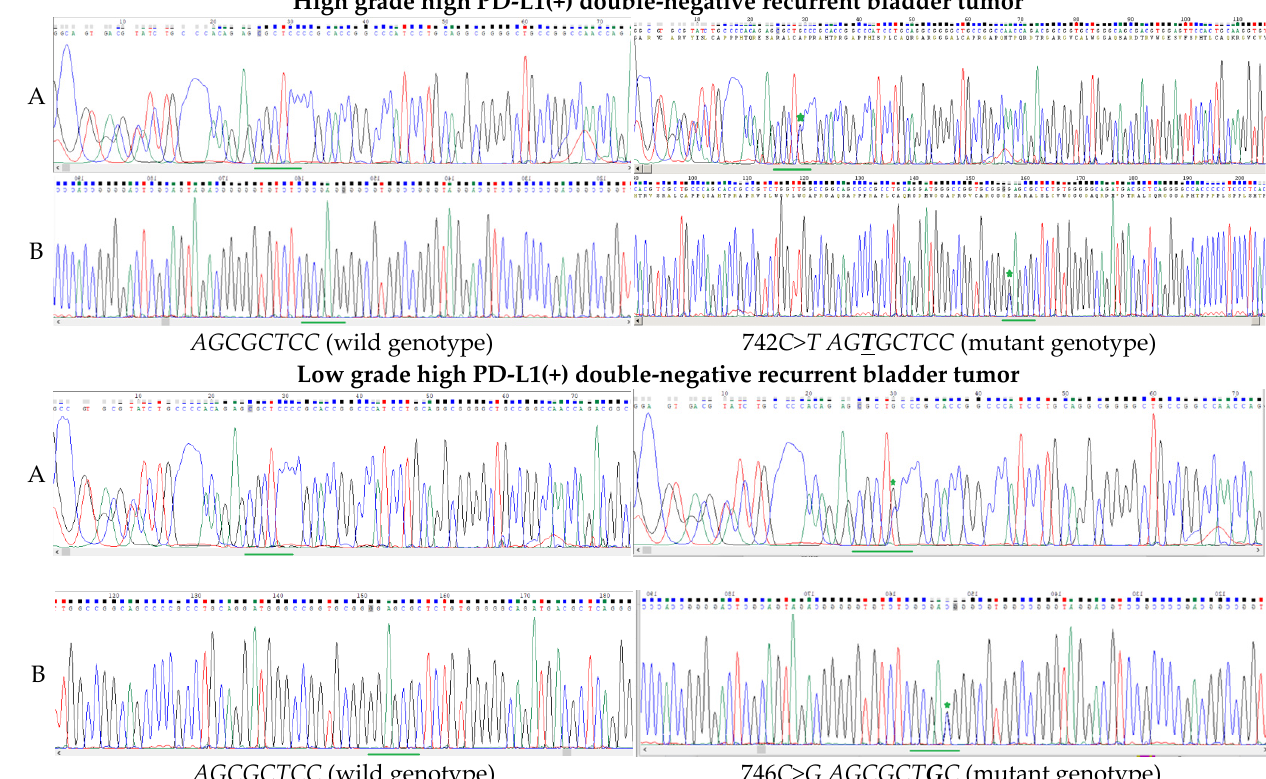
Figure A3. Study design. Appendix B Table A1. Patients’ main gender characteristic and clinicopathological features of the tumors. Sample No